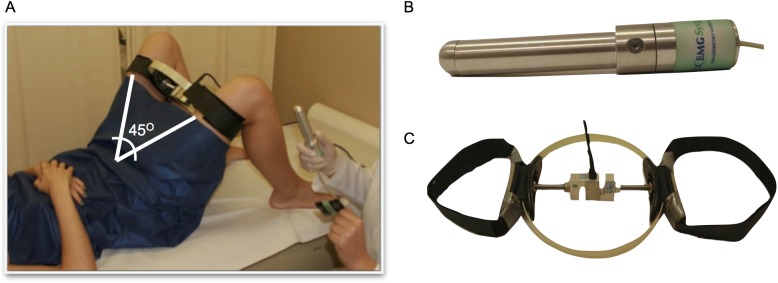
(a) Data acquisition set up, (b) intra-vaginal dynamometer, and (c) thigh dynamometer.